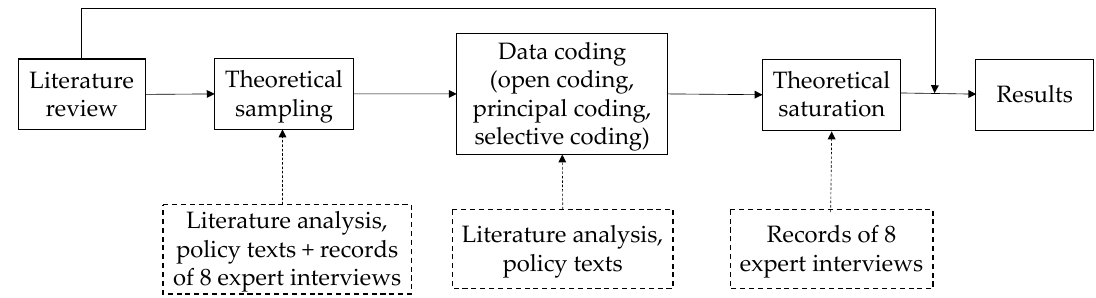
Figure 2. Process of Grounded